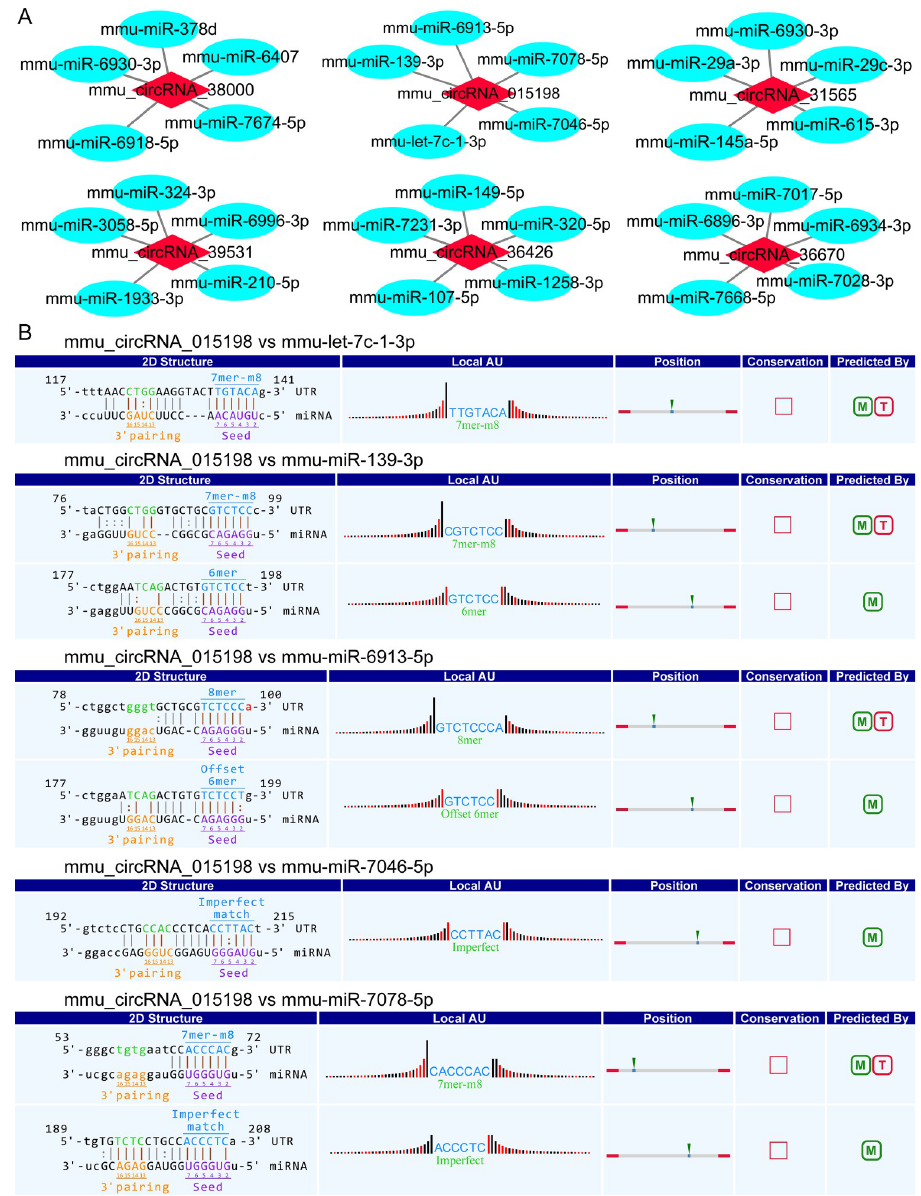
Fig 5. Prediction of circRNA-miRNA interaction. (A) Top 5 predicted targets of 6 validated circRNAs. (B) Predicted interaction sites of mmu_circRNA_015198. M: miRanda; T: TargetScan.